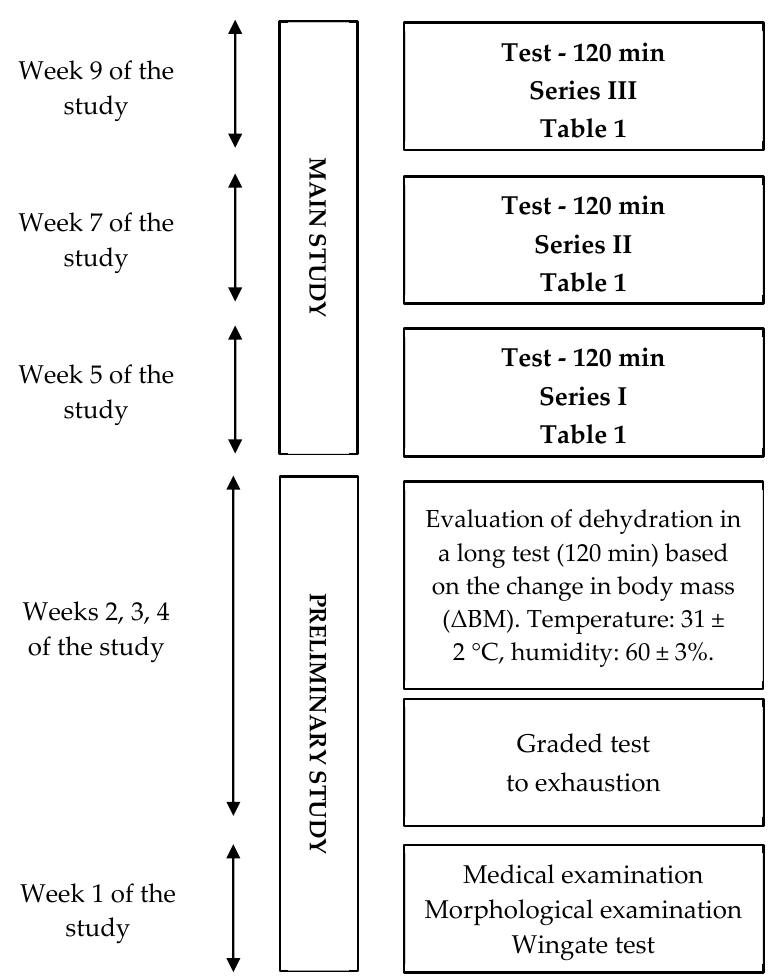
Figure 1. General experimental design.